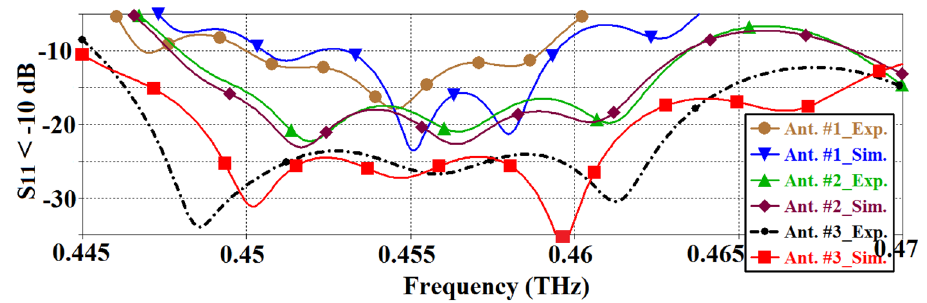
Figure 9. Comparison of the reflection-coefficient response of Ant. #1 (SIW), Ant. #2 (SIW-MTS), and Ant. #3 (SIW-MTS with feedline MTS and short-circuited feedline ends).